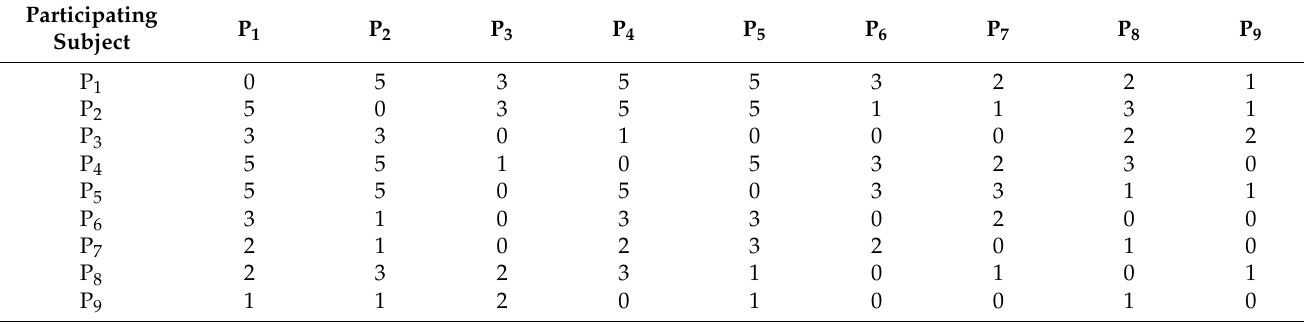
Table 3. The strength matrix of the relationship between stakeholders of CWR.